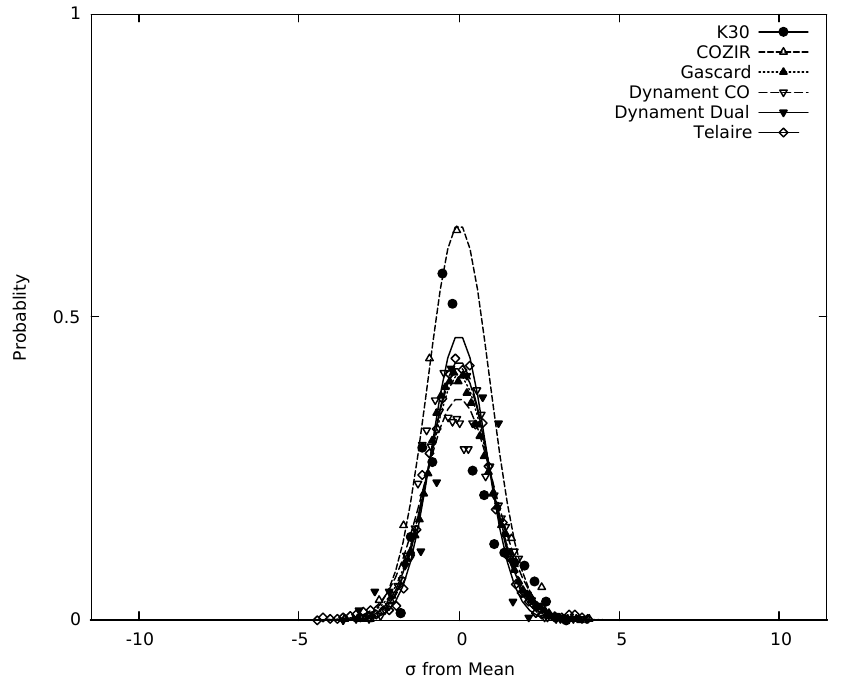
Figure 6. Frequency distribution of the digitized sensor output around the mean response of the sensor (points), along with Gaussian non-linear for each CO sensor around the typical environmental baseline 2 concentration of 400 ppm. Any deviation between the center of the Gaussian fit and the mean are due to significant asymmetry of the frequency distribution around the